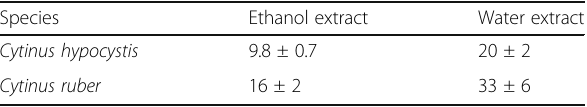
Table 2 Anti-tyrosinase activity of Cytinus hypocistis and Cytinus ruber extracts Species Ethanol extract Water extract Cytinus hypocystis 9.8 ± 0.7 20 ± 2 Cytinus ruber 16 ± 2 33 ± 6 Data expressed as IC 50 ( μ